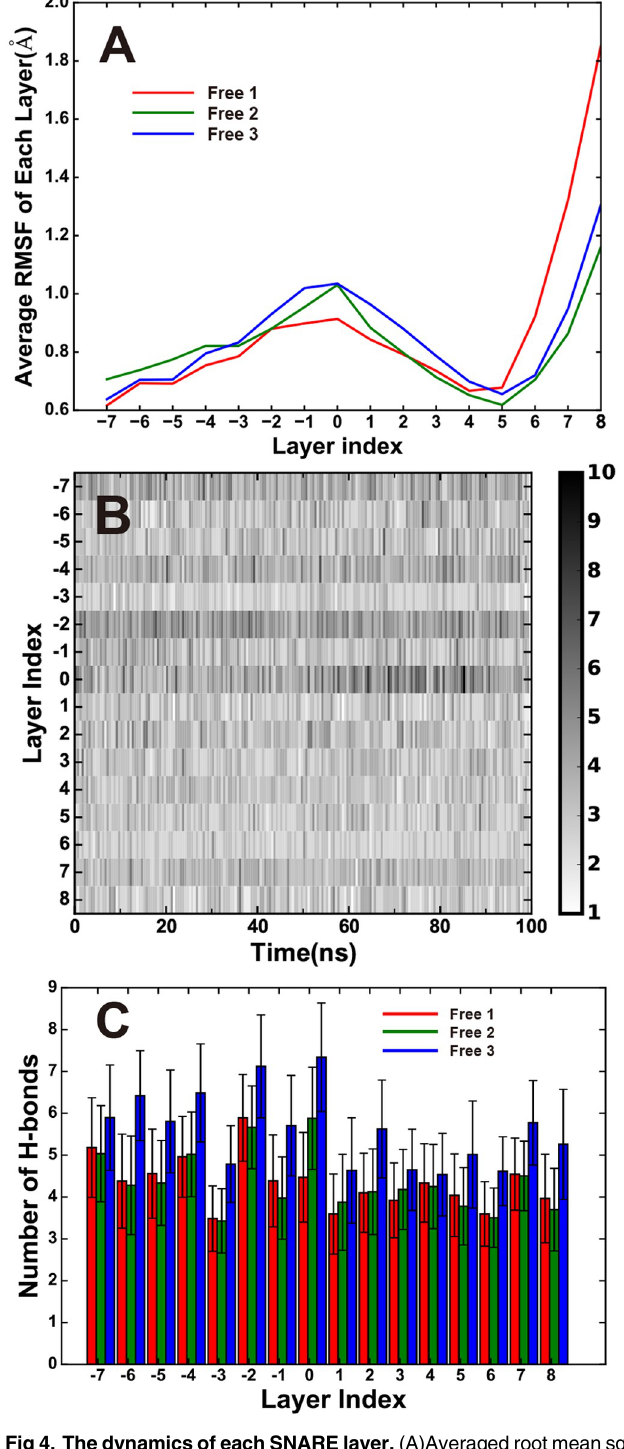
Fig 4. The dynamics of each SNARE layer. (A)Averaged root mean squaredfluctuationof each layer in the simulations. (B) Time-course of the numbersof hydrogenbond betweenthe layer residues with their surroundings for each layers. (C)Averagenumberof Hydrogenbond betweenthe layer residues with their surroundings for the last 20 ns of the two simulation(80–100ns).